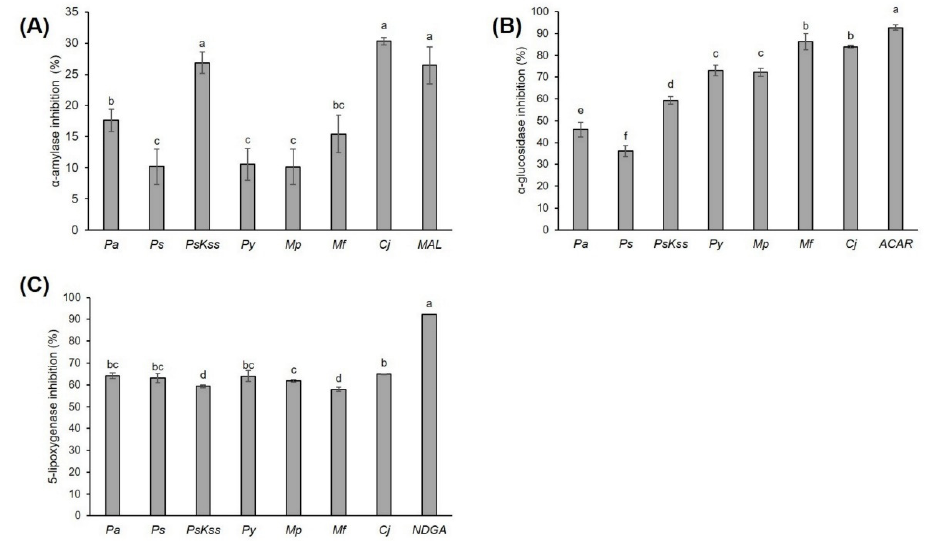
Figure 1. Inhibition of ( A ) α -amylase, ( B ) α -glucosidase, and ( C ) 5-lipoxygenase activity by Rosaceae inflorescences’ extracts (0.80 mg/mL, 0.55 mg/mL and 1.45 mg/mL, respectively). The values represent the mean ± standard deviation of three replicates. Different letters indicate a significant difference among the values (ANOVA, Duncan test, p ≤ 0.05). Pa = P. avium , Ps = P. serrulata , PsKss = P. serrulata ‘Kiku Shidare Zakura’, Py = P. yedoensis , Mp = M. purpurea , Mf = M. floribunda , Cj = Chaenomeles japonica , MAL = maltose 0.80 mg/mL, ACAR = acarbose 0.55 mg/mL, NDGA = nordihydroguaiaretic acid 0.15 mg/mL.